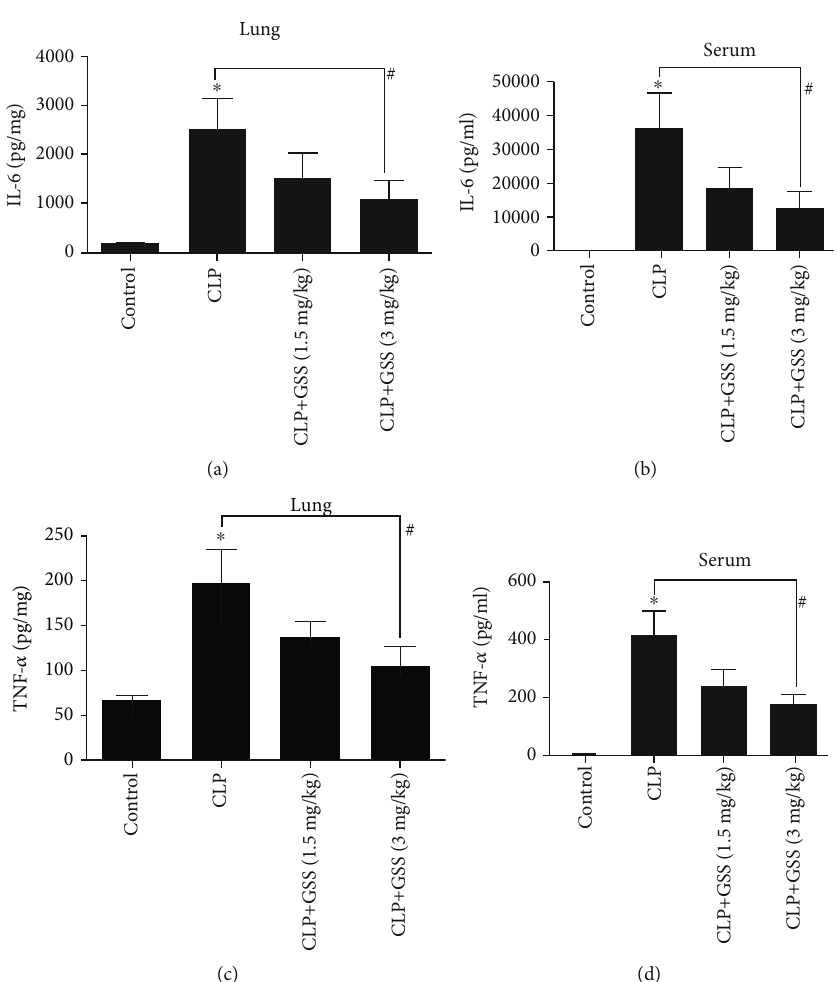
Figure 2: GSS blocks sepsis-induced in fl ammatory response in the lung tissue and the serum of mice. The mouse lungs harvested 24h after CLP application. (a, c) Sepsis in C57BL/6J mice was induced by the CLP procedure after pretreatment of GSS, and the volume of TNF- α and IL-6 in the lung tissue was checked by ELISA. (b, d) The change of TNF- α and IL-6 in the serum of mice was detected by ELISA. ∗ P < 0 : 05 versus negative control. # P < 0 : 05 versus the corresponding CLP treatment